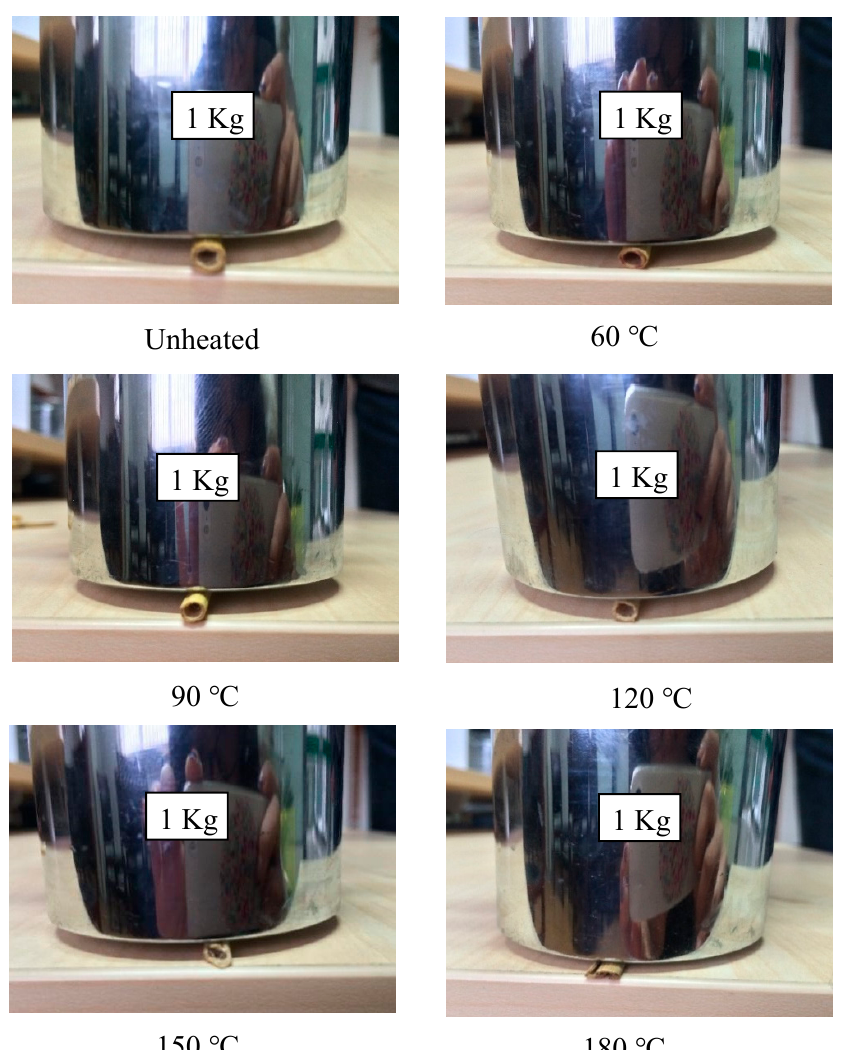
Figure 11. Real photos of straw units drying at di ff erent drying temperatures under the approximate pressure of 1 bar.